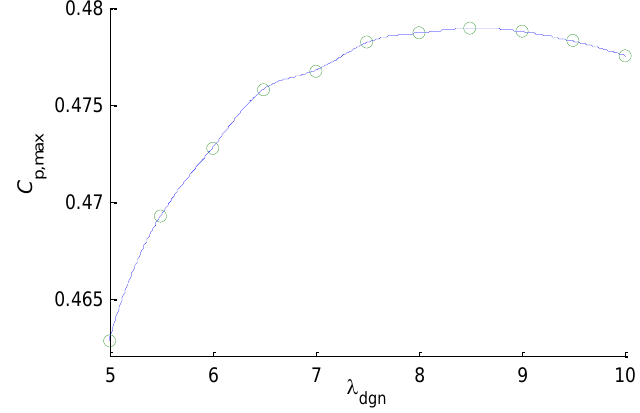
Figure 1. The variation of C p,max versus λ dgn obtained from simulations on the WindPACT turbine.